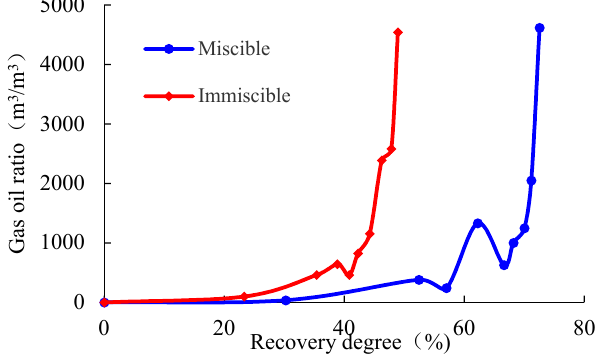
Figure 5. The relationship between recovery degree and gas–oil ratio (0.096 mD core).